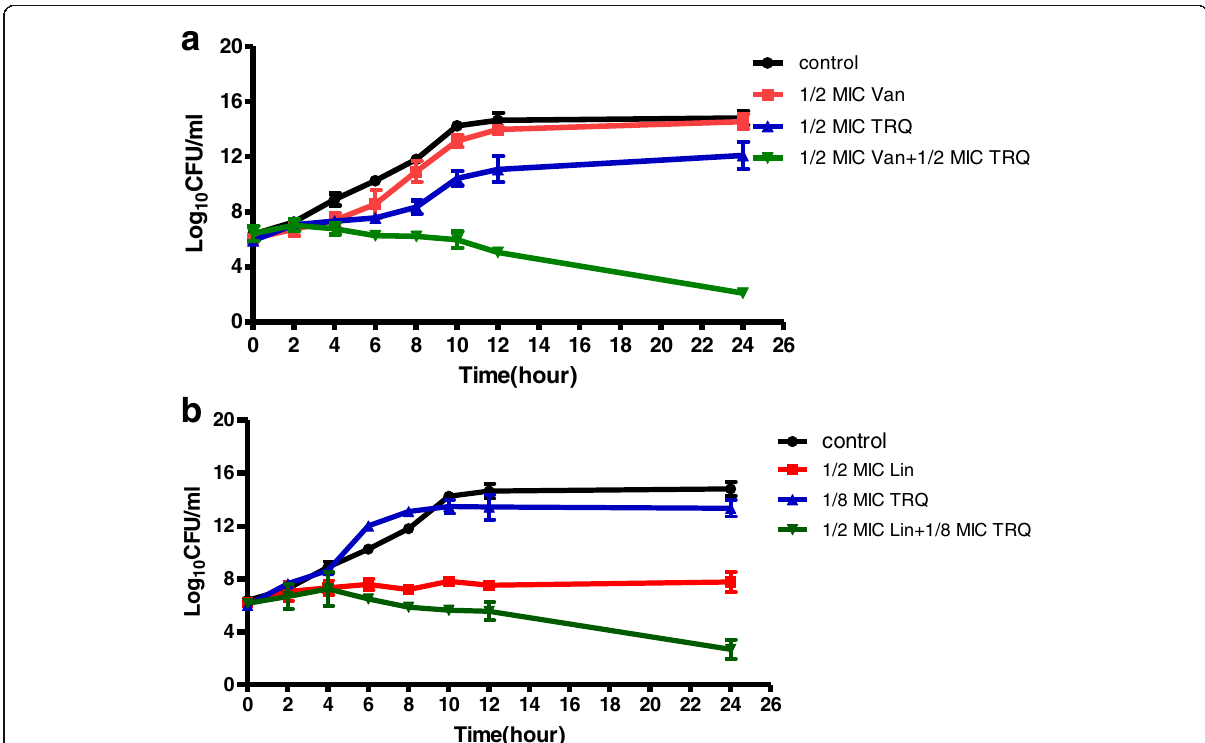
Fig. 2 Time-kill curves of TRQ, vancomycin and linezolid alone and in combinations against MRSA (A. TRQ with vancomycin; B. TRQ with